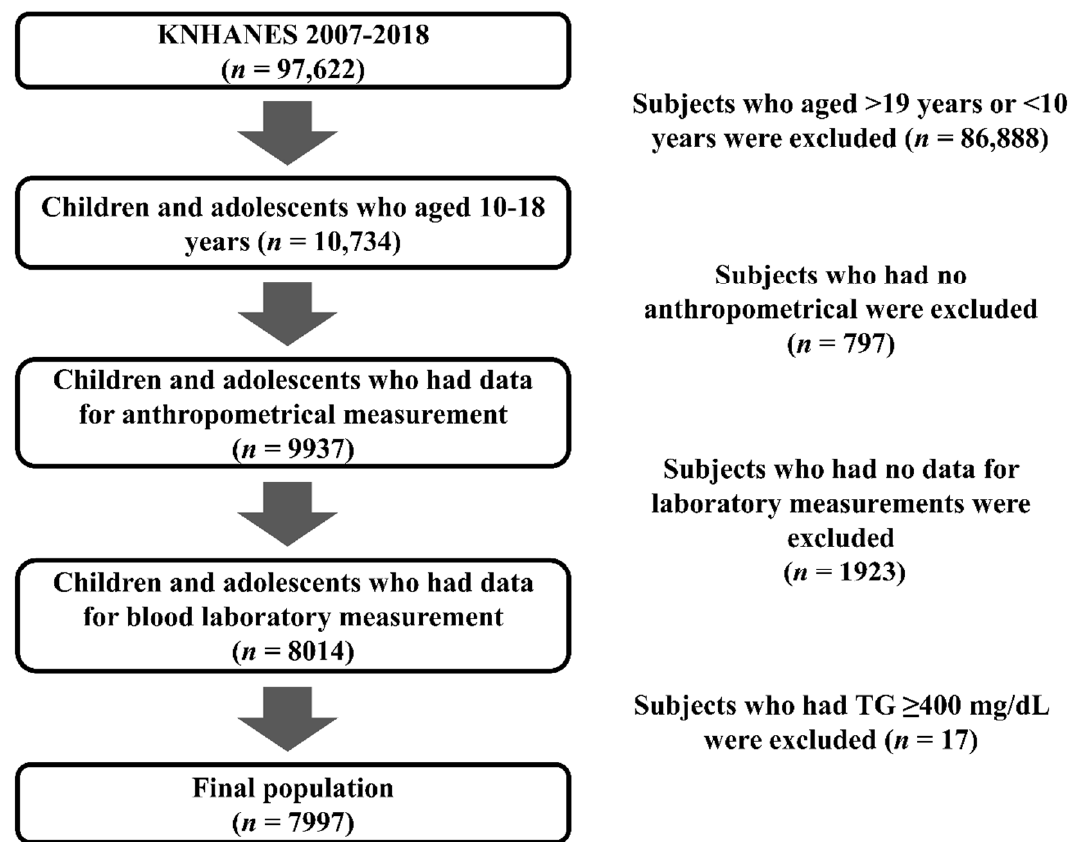
Figure 1. Flow chart of study population.